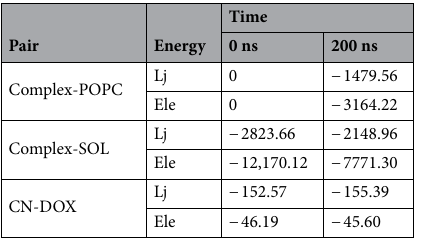
Table 1. Average electrostatic (Ele) and van der Waals (Lj) interaction energies between the different components of the investigated system.